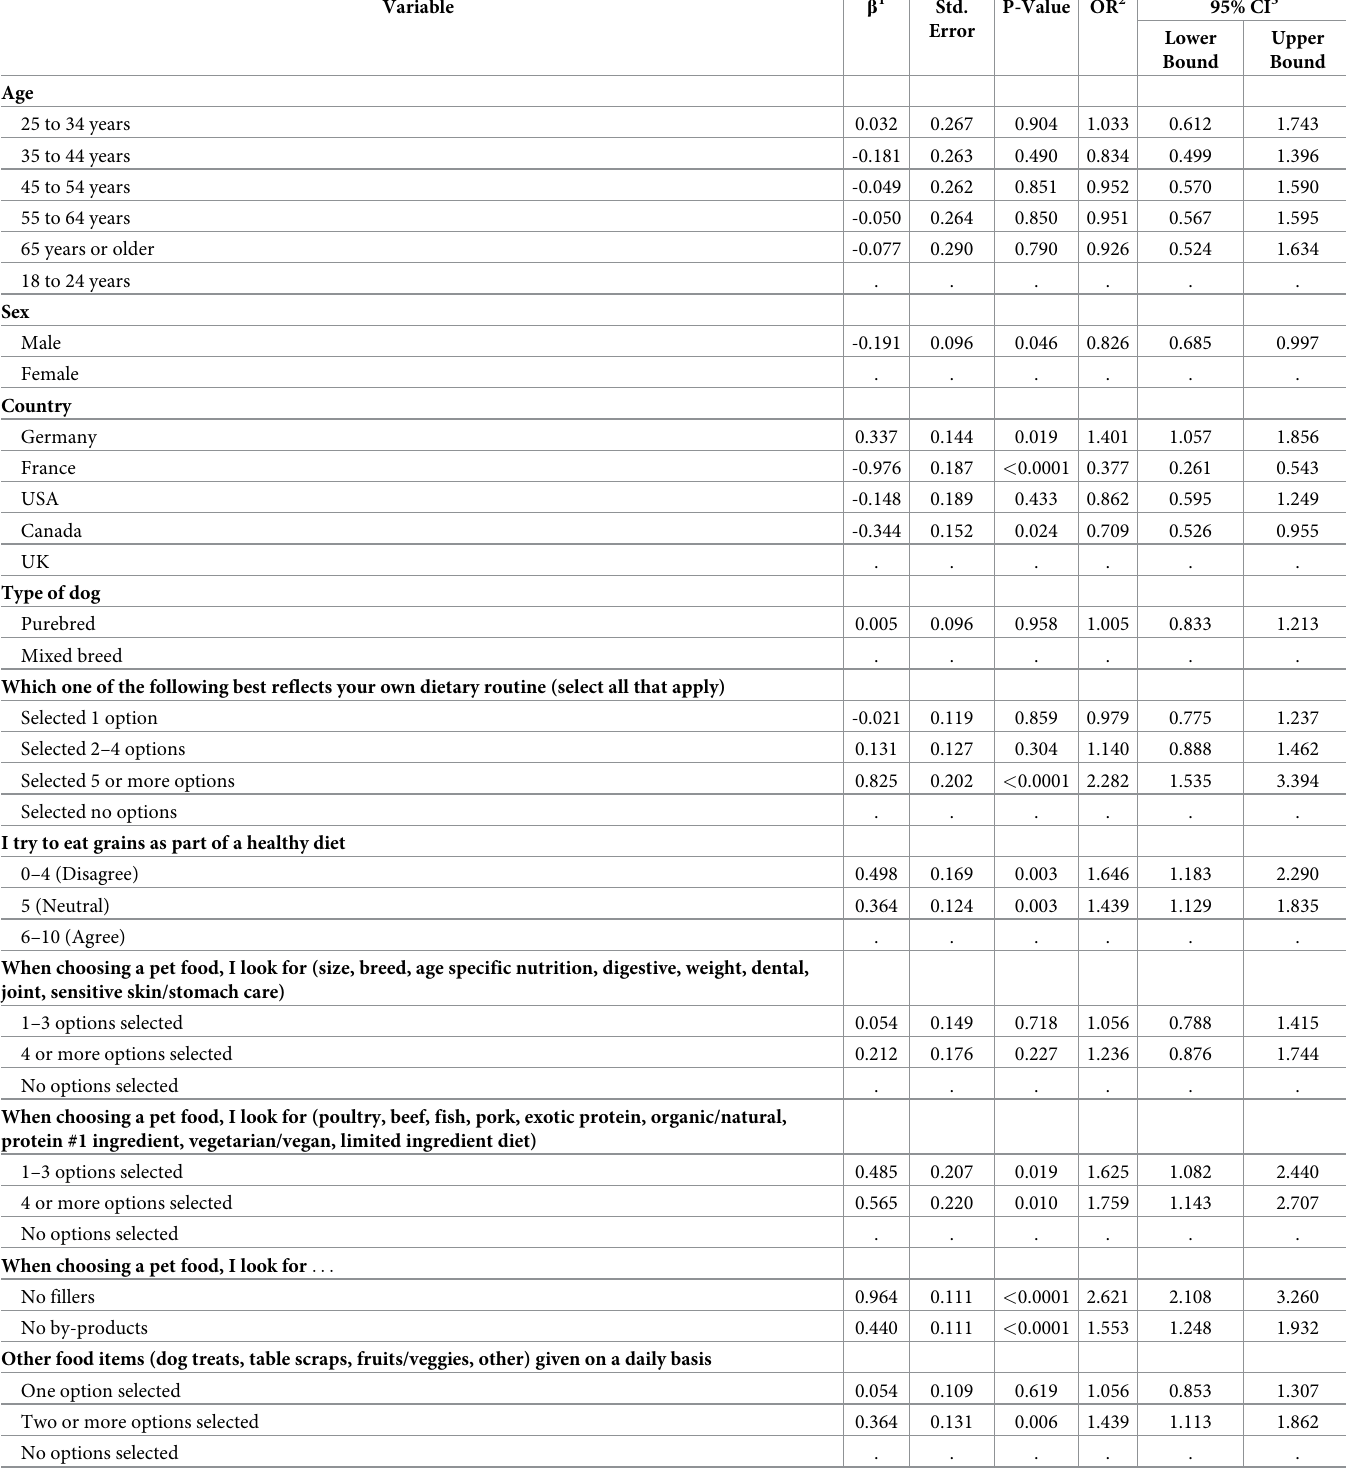
Table 4. Multinomial logistic regression parameter estimates for the Diet